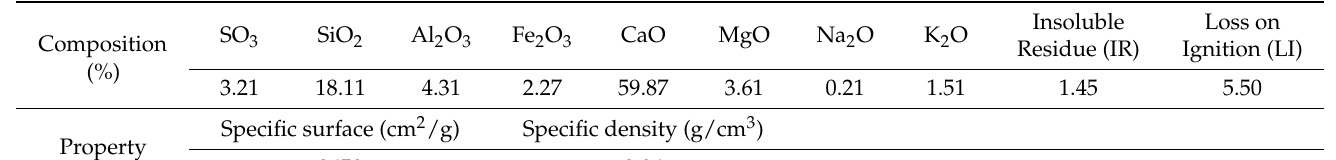
Table 2. Chemical and physical properties of studied cement.